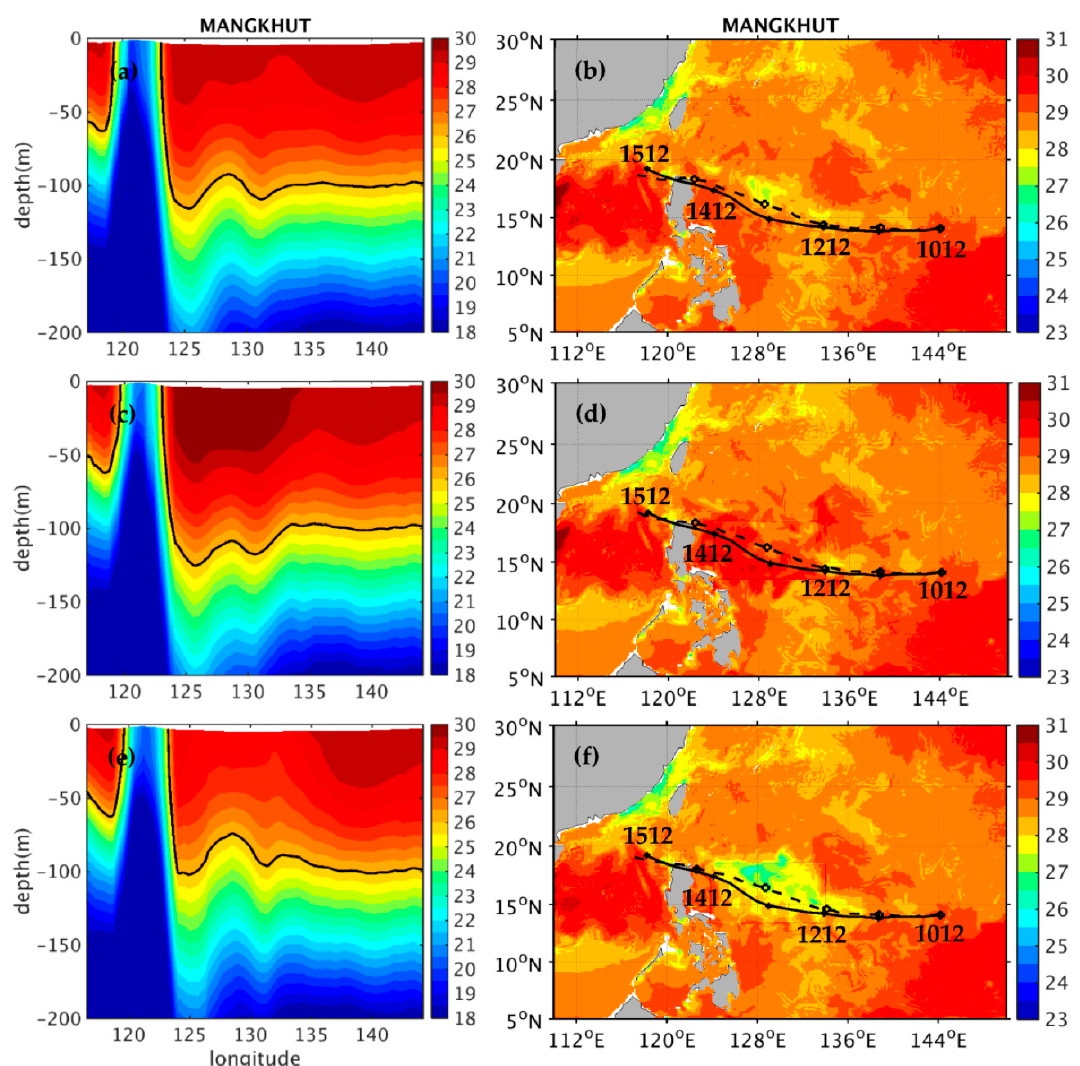
Figure 6. Along-track vertical cross section of ocean temperature averaged in a 200 km radius of the typhoon center at the initial time (shaded colors in °C) for ( a ) MK-CTL, ( c ) MK-Tp1, and ( e ) MK-Tm1. ( b ), ( d ), and ( f ) are the same as in ( a ), ( c ), and ( e ), respectively, but for the sea surface temperature at 96 h (1200 UTC 14 September). In ( a ), ( c ), and ( e ), the black line represents the 26 °C isotherm. The dashed and solid lines in ( b ), ( d ), and ( f ) show the best track from the JTWC and simulated track, respectively.